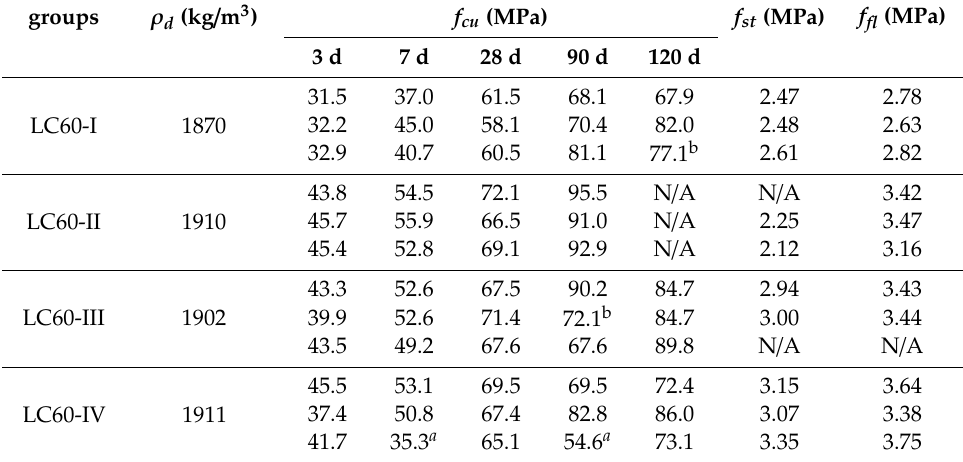
Table 5. Test results of specimens.